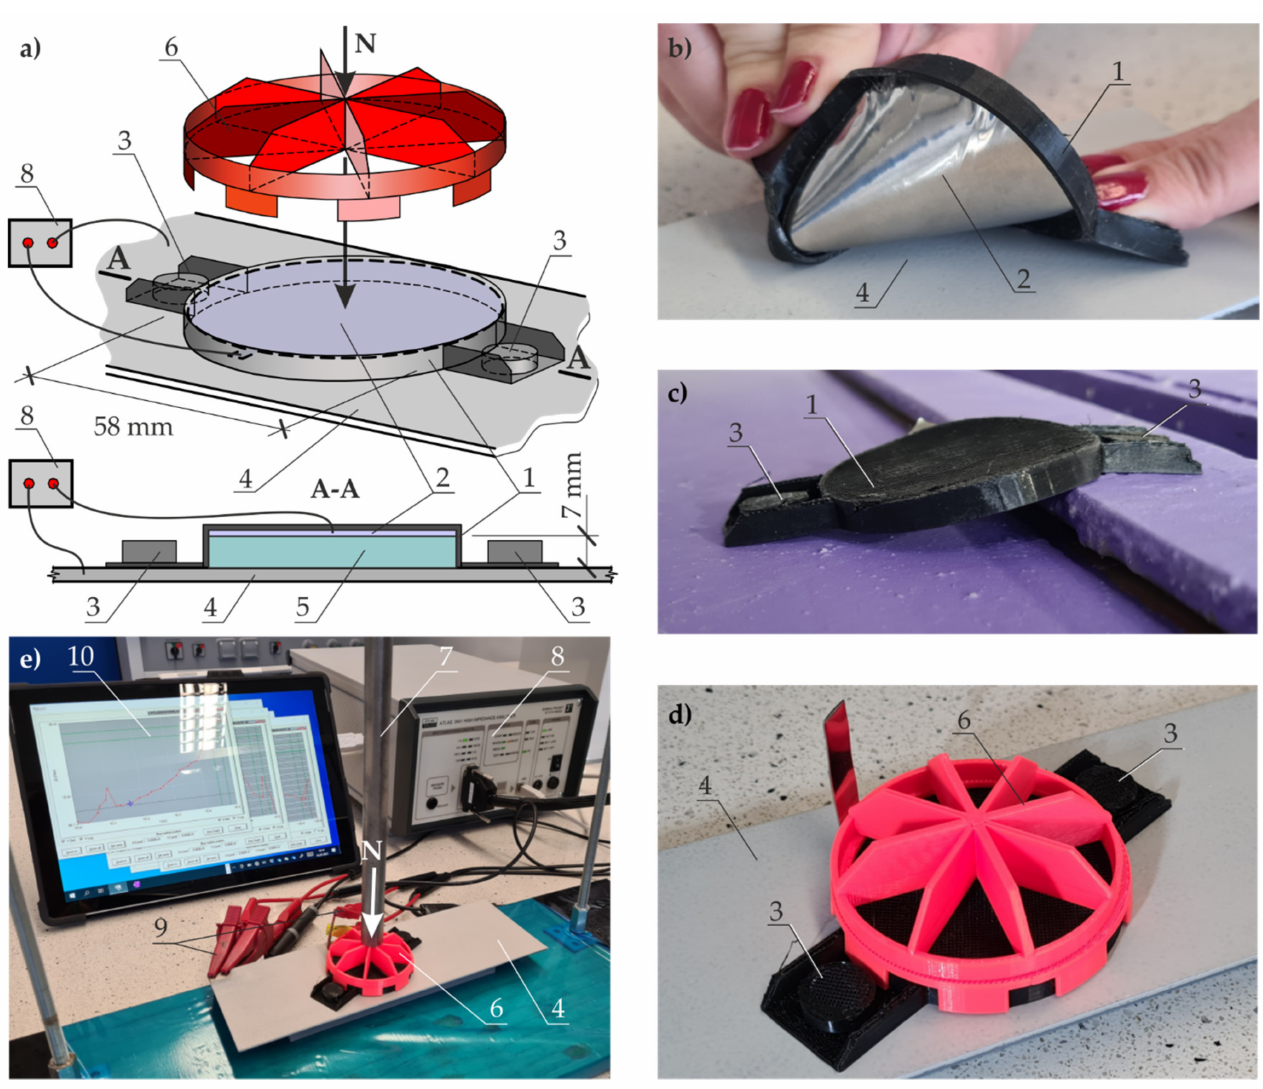
Figure 5. Measuring cell and the test stand in the first stage of EIS testing of anti-corrosion coatings: ( a ) schematic view of the measuring head on the sheet with paint coating; ( b ) head flexibility; ( c ) adjusting head shape to stepped connection between the test elements; ( d ) view of the head with a cap to conduct tests with liquid electrolyte; ( e ) view of the test stand and the head with a cap to conduct tests with liquid electrolyte. 1—flexible measuring cell; 2—flexible auxiliary electrode in the form of film made of stainless steel; 3—neodymium magnets; 4—sheet with paint coating; 5—liquid or gel electrolyte; 6—head cap for measurements with liquid electrolyte; 7—screw pressure; 8—high impedance analyser; 9—clamps for high impedance analyser; 10—hybrid